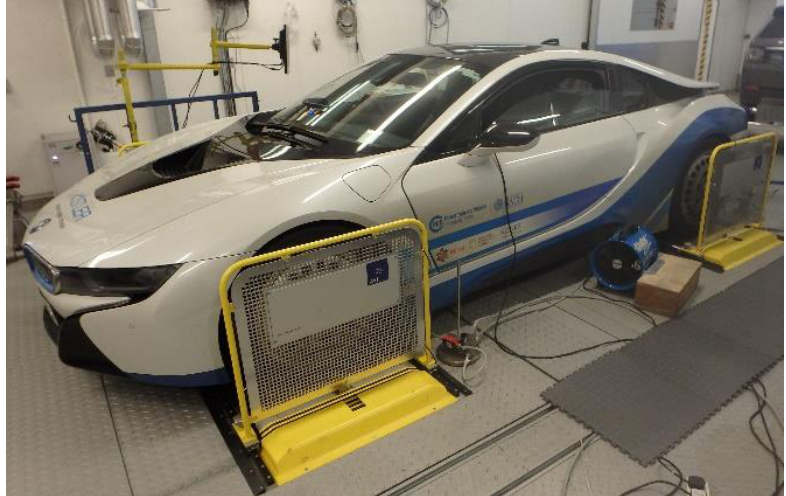
Figure 3. The BMW i8 test vehicle installed on the chassis dynamometer facility at IAAPS, University of Bath [26].